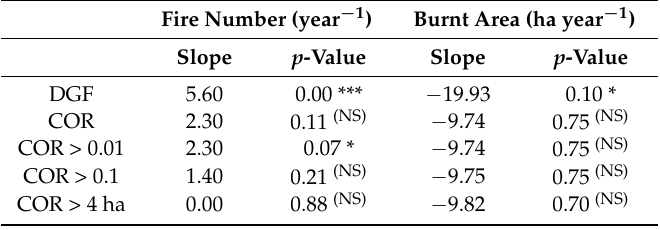
Table 4. Slope and p -value of the temporal regression of fire number and burned area over the 1985–2010 period for Tunisia (Theil-Sen test). *** p -value < 0.01, ** p -value < 0.05, * p -value < 0.1. NS non-significant. Temporal trend is analyzed for all fires in DGF and COR, and for fire sizes >0.01 ha, >0.1 ha and >4 ha in COR.